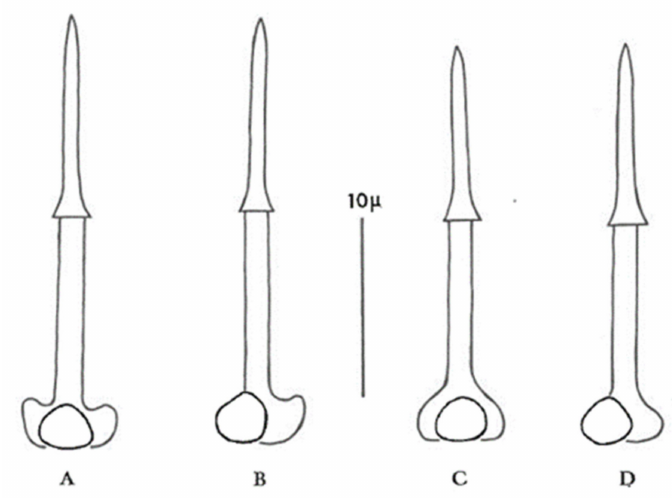
Figure 2. Stylets of second-stage juveniles of G. pallida (diagrams ( A , B )) and G. rostochiensis (diagrams ( C , D )) (after Stone